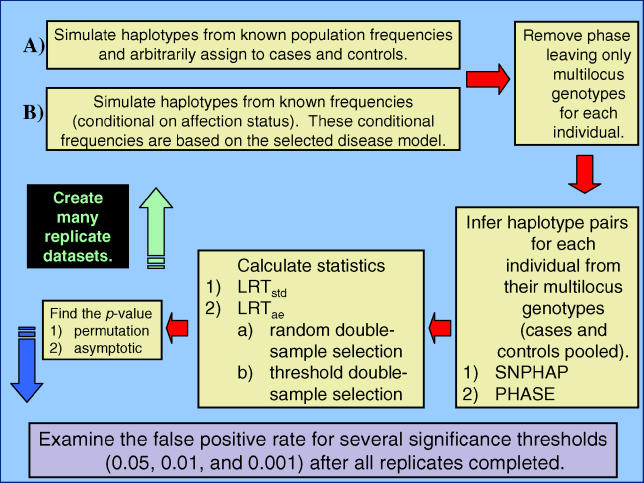
Schematic Flow Chart Illustrating the Procedure Employed for Computing Type I Error and Power by Way of Data Simulation(A) shows type I error, and (B) shows power by way of data simulation.